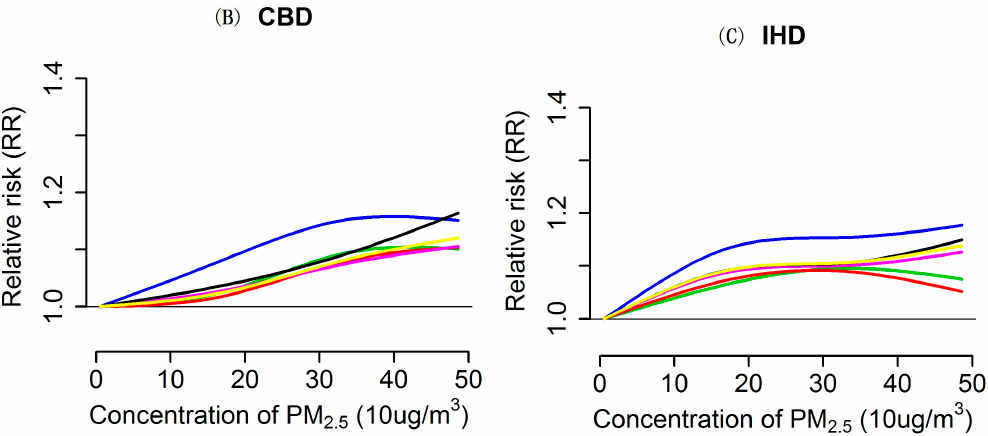
Figure 1. Exposure-response relationships for PM 2.5 (lag 0–1) with cardiovascular (CVD), cerebrovascular (CBD), and ischemic heart disease (IHD) mortality for whole population, according to single pollutant UDL models. Values are estimated relative risk of mortality associated with PM 2.5 relatives to lowest value (5.83 µ g/m 3 ). Base model(blue lines) adjusted effects of temperature and humidity only for two days ( modeled as two days moving average), whereas the lines with color of green, red, pink, black and yellow represent relationships from extensively adjusted models that with simultaneously adjusted cumulative effects of temperature and relative humidity for 7, 14, 21, 28 and 40 days, respectively.